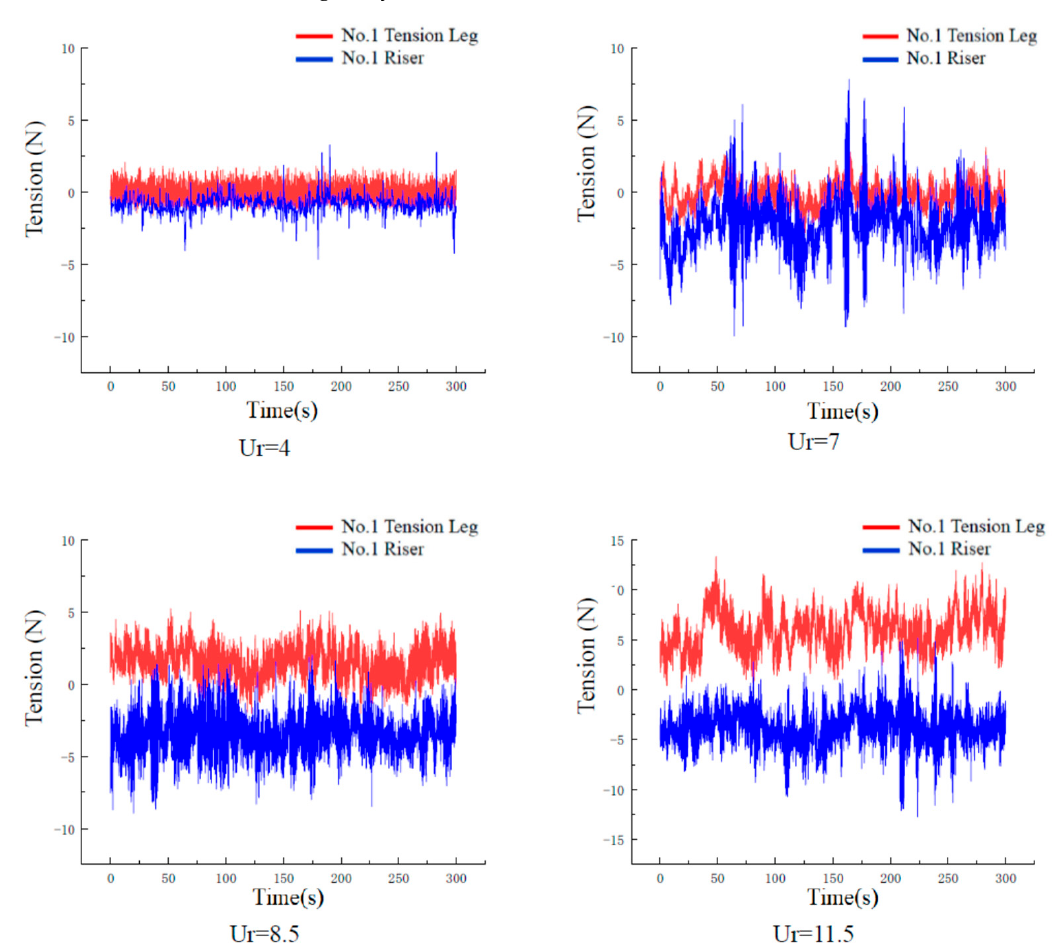
Figure 6. Time history response curve of tension of No. 1 tension leg and No. 1 riser.